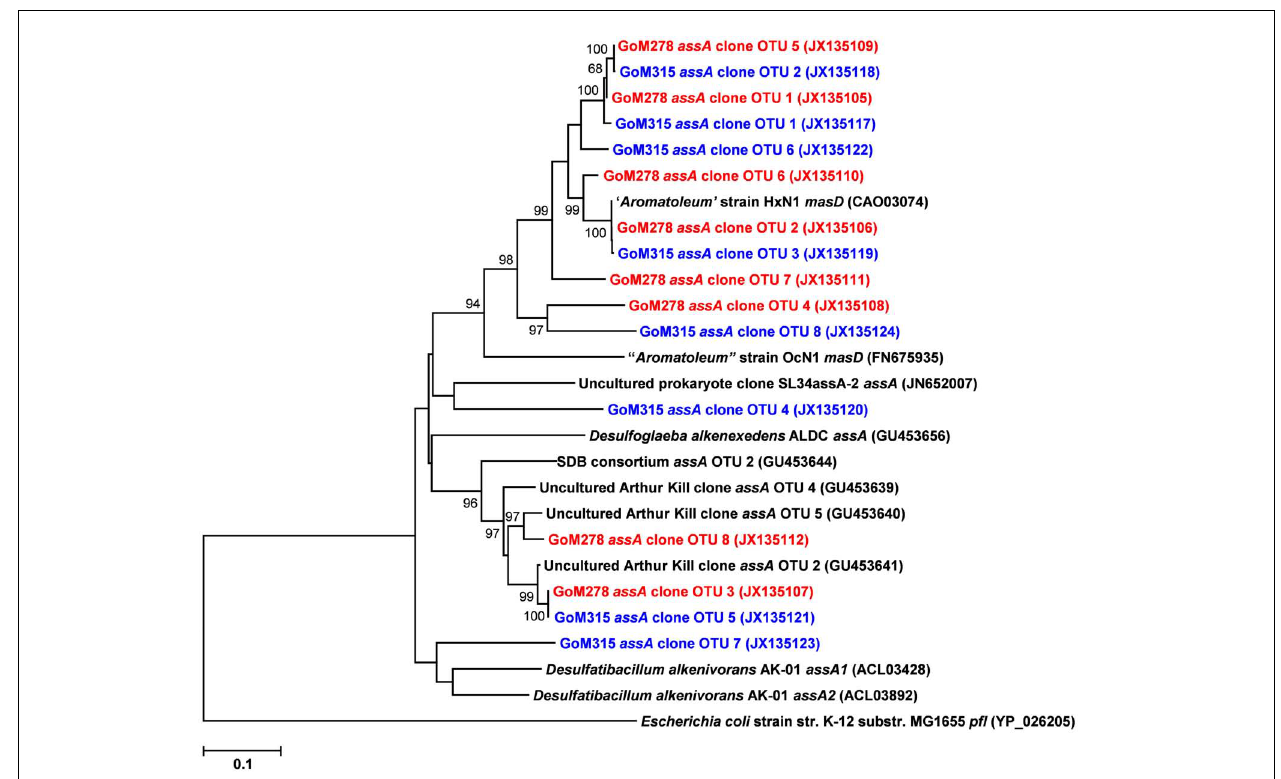
(scale bar), with pairwise deletion and performing 10,000 bootstrap replicates. Bootstrap values below 65 are not shown. Pyruvate formate lyase ( pfl ) served